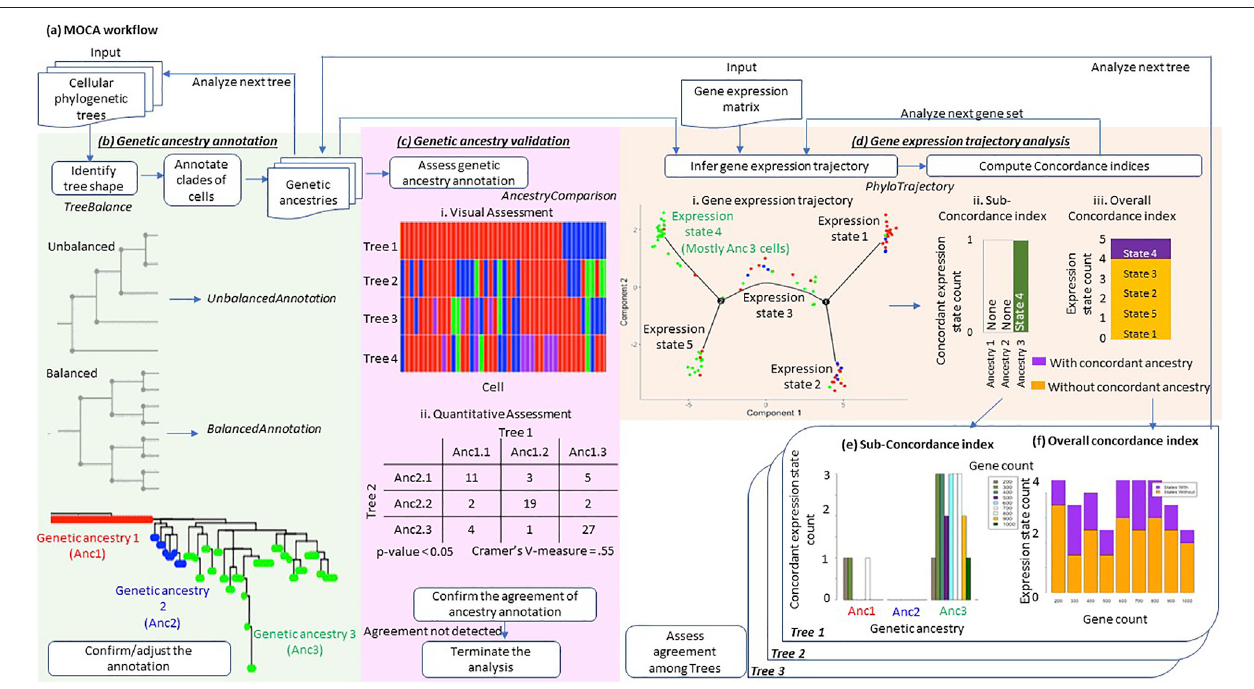
FIGURE 1 | Overview of MOCA. (A) MOCA work fl ow. MOCA analyzes cellular genetic variations and gene expression pro fi les from scRNA-seq data. (B) MOCA takes as input a phylogenetic tree if the genetic ancestry of each cell is not provided. If the type of tree shape (balanced or unbalanced) is unclear, MOCA ’ s TreeBalance function fi rstsuggeststhetree ’ sshape.Basedonthetreeshape,MOCAsuggestsusingeitherthe BalancedAnnotation orthe UnbalancedAnnotation functiontoidentify groups of genetically similar cells, which are de fi ned as genetic ancestries. The phylogeny was inferred by BEAM analysis of 139 variants in the MGH26 data. (C) MOCA ’ s AncestryComparison function visualizes and quanti fi es the relationship between inferred genetic ancestry annotations among different phylogenies. For each pair of trees (genetic ancestry annotations), Cramer ’ s V effective size together with p -value is produced. (D) Using the genetic ancestries together with the gene expression matrix (input), MOCA ’ s PhyloTrajectory function infers the expression trajectory. From the inferred trajectory, PhyloTrajectory calculates the Sub- concordance index ( SCI ) for each genetic ancestry and Overall concordance index ( OCI ). The SCI index is the count of expression states which are largely unique to a given genetic ancestry, e.g., > 80% of cells. The OCI is the ratio of total expression states that are largely unique to any single ancestry compared to all the expression states identi fi ed. (E) The SCI index for each genetic ancestry for different numbers of genes, 200 – 1,000. (F) The OCI of the tumor across gene sets, 200 – 1,000. These indices are produced for each